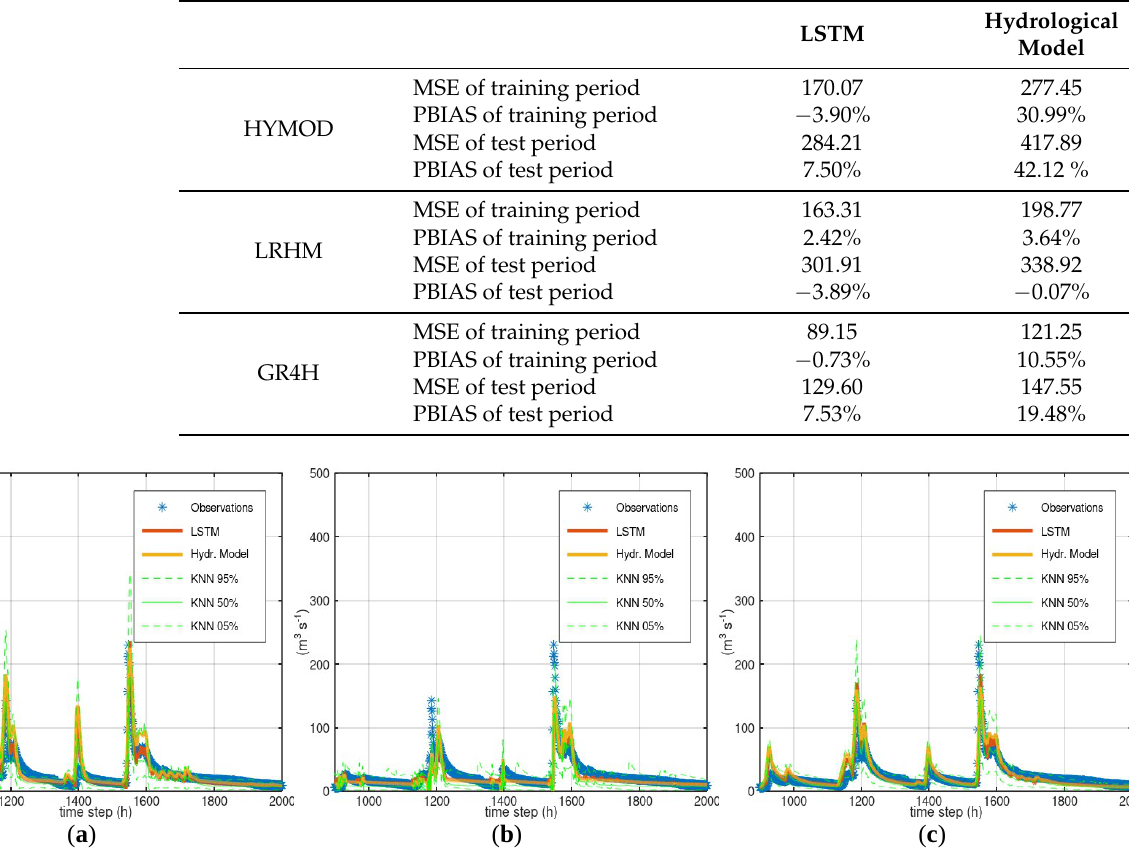
Table 2. Performance indicators of Sieve River case study.